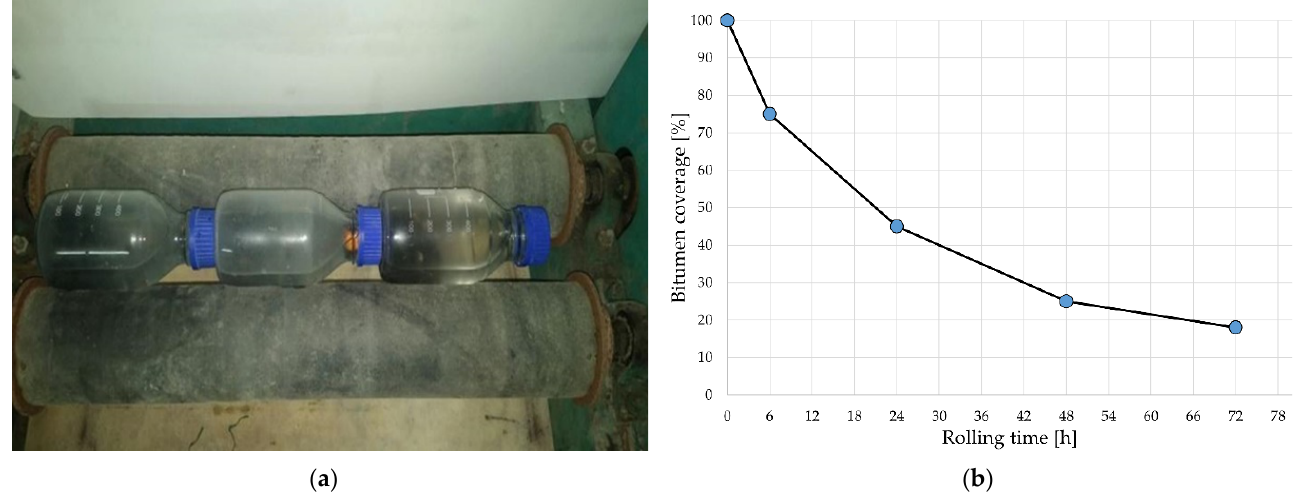
Figure 1. ( a ) The three bottles containing the mixtures during the rolling-test; and ( b ) typical results of the rolling-bottle method.